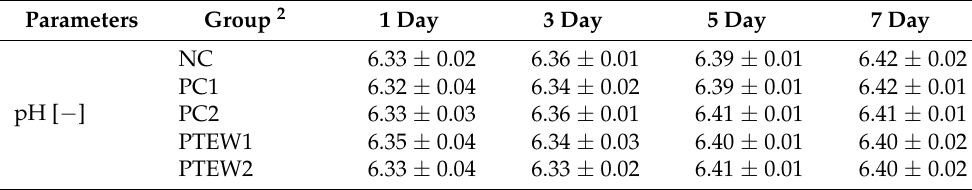
Table 2. The effect of plasma-treated egg white on pH (mean ± SE 1 ) of liver p â t é s during storage.